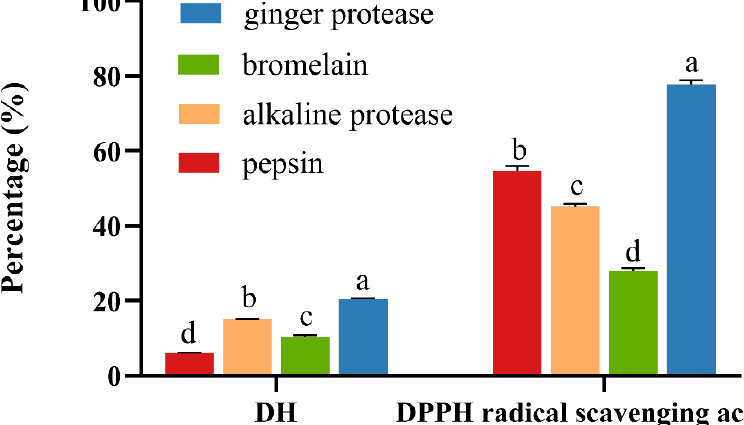
Figure 2. DH and DPPH radical scavenging activity of hydrolysates prepared by different proteases. Data were presented as mean ± SD ( n = 3). Bar graphs followed by different letters indicate significant differences ( p < 0.05) (ANOVA/Dunnet’s test). DH: degree of hydrolysis. DPPH: 2,2-diphenyl-1-picrylhydrazyl.